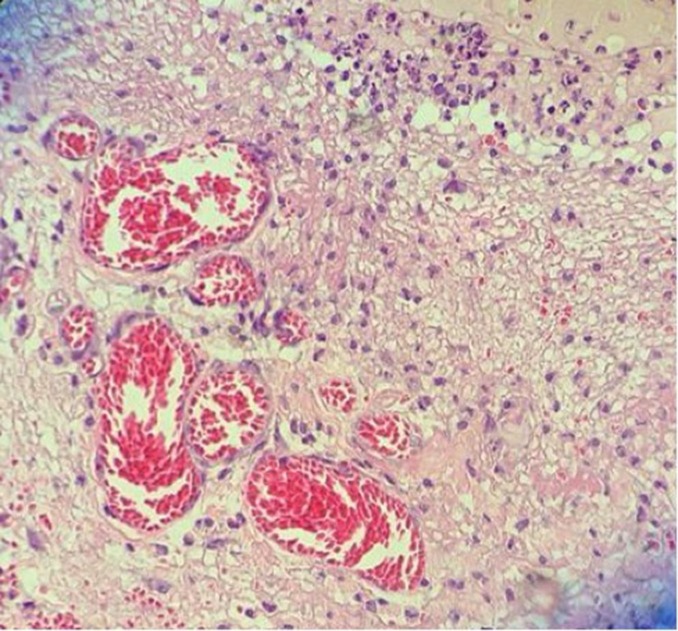
Hematoxylin eosin staining for experimental group/14 day subset.